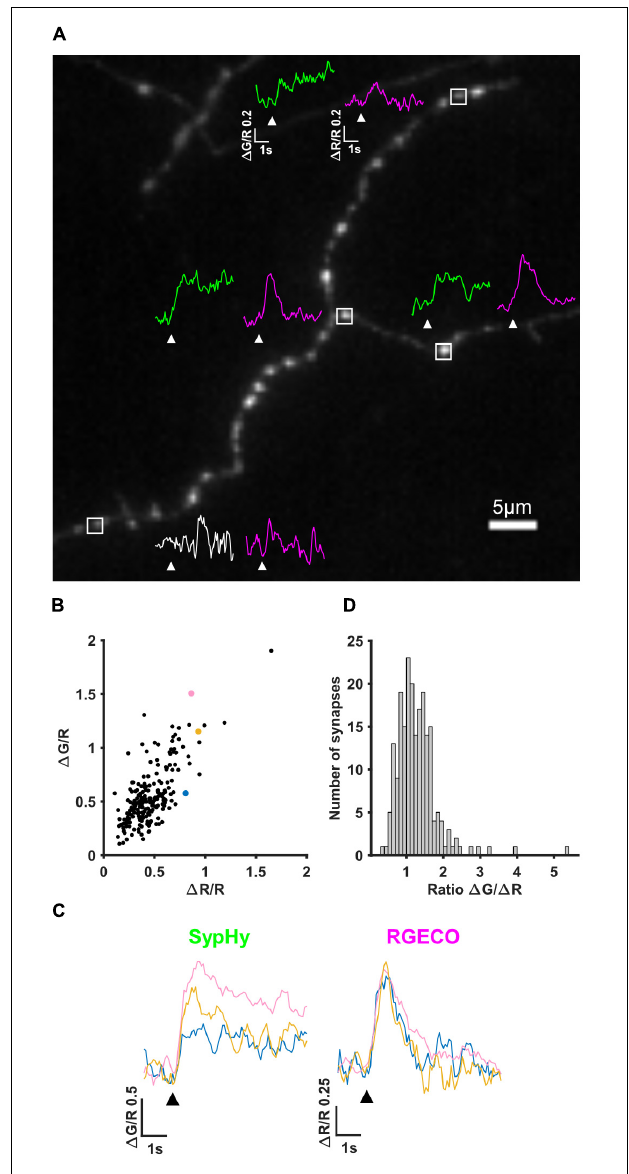
FIGURE 2 | SypHy-RGECO responses to 10AP stimuli. (A) Image of an axon transfected with SypHy-RGECO (green channel (SypHy) shown). Representative traces of SypHy ( (cid:49) G/R, green/white) and RGECO ( (cid:49) R/R, magenta) responses to 10AP stimuli are shown for boutons with a detectable calcium influx (peak response greater than 3SD of the baseline), associated with SV release (green traces) or failure to release (bottom synapse, white trace) assessed using the same threshold. White boxes indicate selected boutons, all traces shown on the same scale, white arrows indicate stimulation. (B) Cells were stimulated with a 10AP 20 Hz stimulus. The change in fluorescence from baseline ( (cid:49) G and (cid:49) R) was normalised to the basal RGECO fluorescence (R) for each synapse. (cid:49) G/R and (cid:49) R/R responses from all synapses show a positive correlation (Spearman’s rank correlation, r = 0.633, p = < 0.0001, n = 211 synapses). (C) SypHy (left) and RGECO (right) traces from 3 synapses (coloured points in B ) with a similar amount of calcium influx (RGECO) in response to a 10AP stimulus but a different level of neurotransmitter release (SypHy). Black arrows indicate stimulation. (D) Distribution of the ratio (cid:49) G/ (cid:49) R indicating the calcium dependence of release (for the synapses shown in B